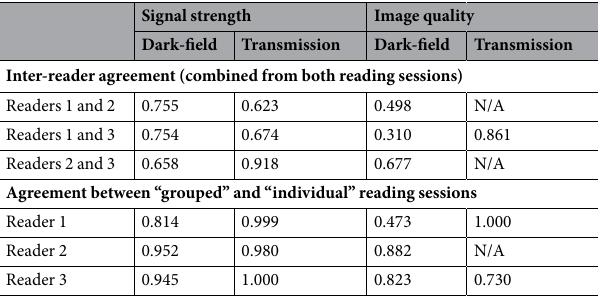
Table 1. Inter-reader agreement (both reading sessions) and agreement for each reader between “grouped” and “individual” reading sessions. Agreement is given in Spearman’s rho. Values of 0.81–1.0 are considered as almost